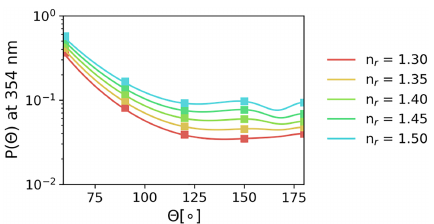
Figure A2. Phase function P((cid:50)) at 354nm of the parameterized Mie-scattering aerosol in sensitivity studies as a function of n r (with r g = 0 . 15µm and n i = 0 . 06). The markers in the plot correspond to values when (cid:50) = 60, 90, 120, 150, 180 ◦ .